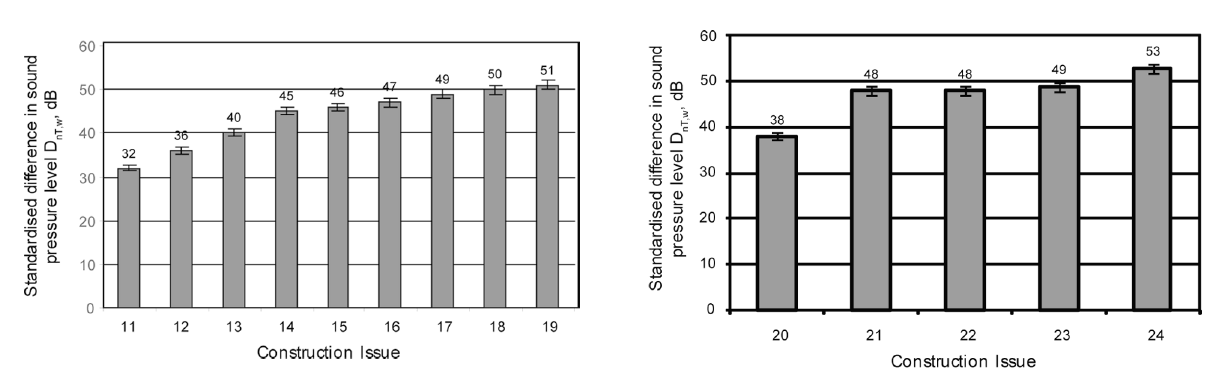
Fig. 11. Results of the standardised difference in sound pressure level D nT,w of structures